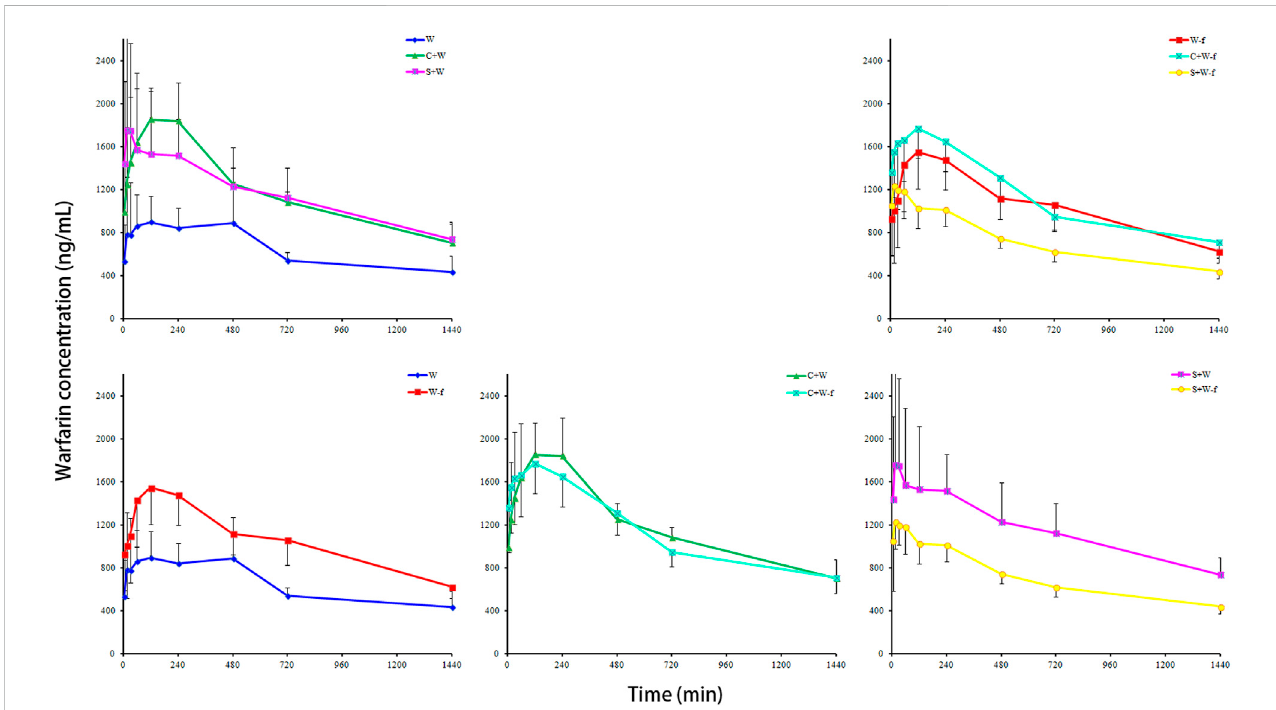
FIGURE 4 The pharmacokinetics effects of Chuanxiong Rhizoma on warfarin in MCAO rats (n = 8). W: MCAO rats with oral administration of warfarin; W-f: pseudo germ-free MCAO rats with oral administration of warfarin; C + W: MCAO rats with oral co-administration of warfarin and Chuanxiong Rhizoma; C + W-f: pseudogerm-freeMCAOratswithoralco-administrationofwarfarinandChuanxiongRhizoma.S+W:MCAOratswithoralco-administrationofwarfarinand senkyunolide I; S + W-f: pseudo germ-free MCAO rats with oral co-administration of warfarin and senkyunolide I.